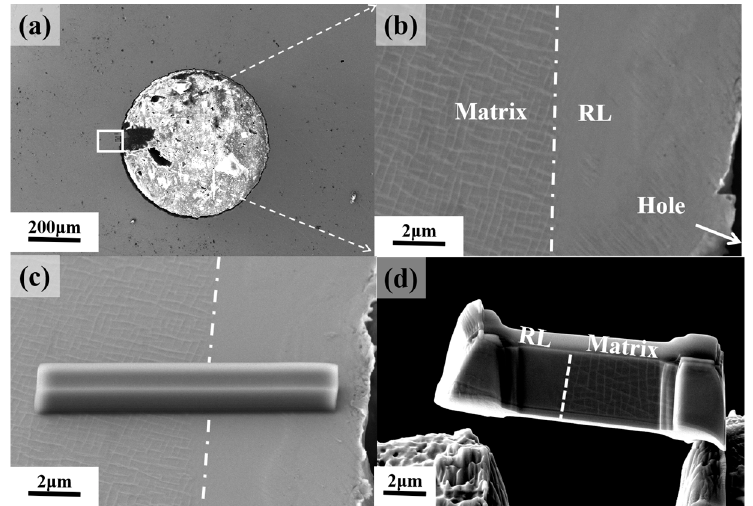
Figure 1. TEM sample preparation: ( a ) The selected specified region with both the matrix and recast layer. ( b ) Microstructure of the selected region. ( c ) The exact location of the TEM sample. ( d ) The prepared sample using FIB. The recast layer (left) and matrix (right) are shown in the sample.